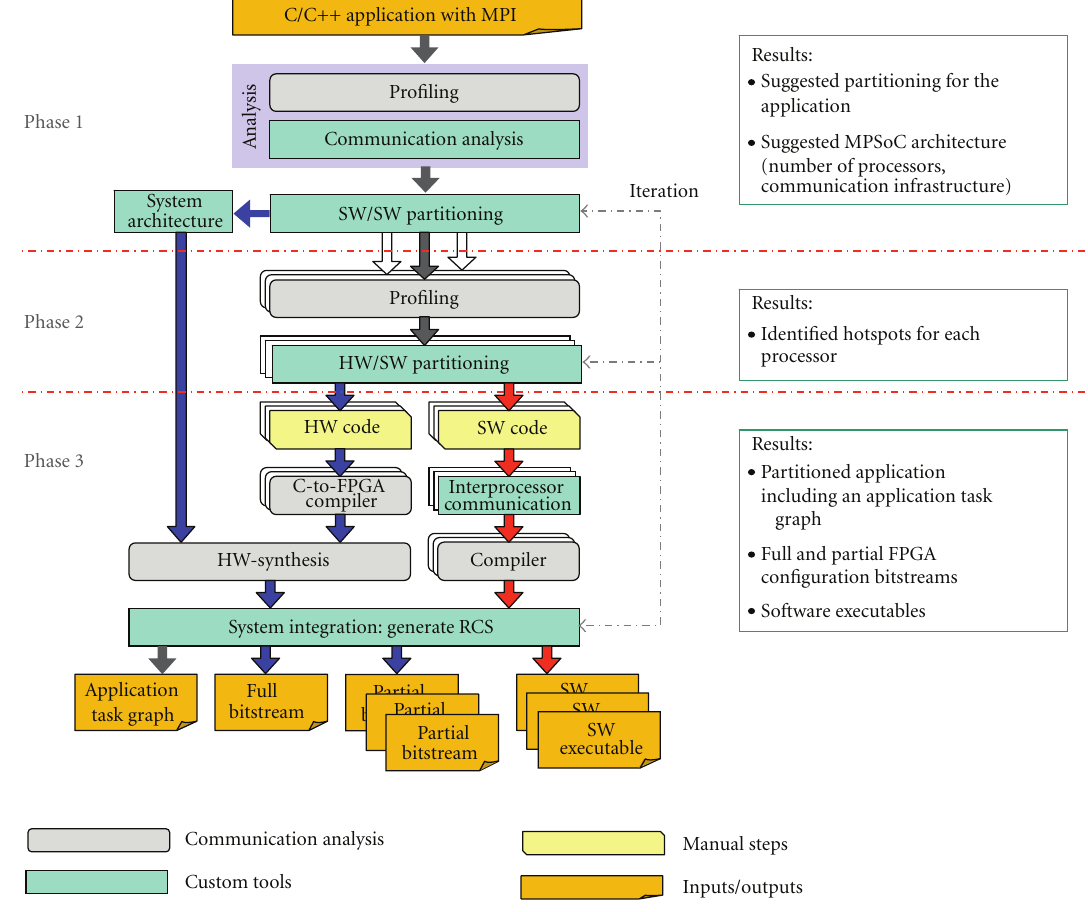
Figure 2: Design methodology of